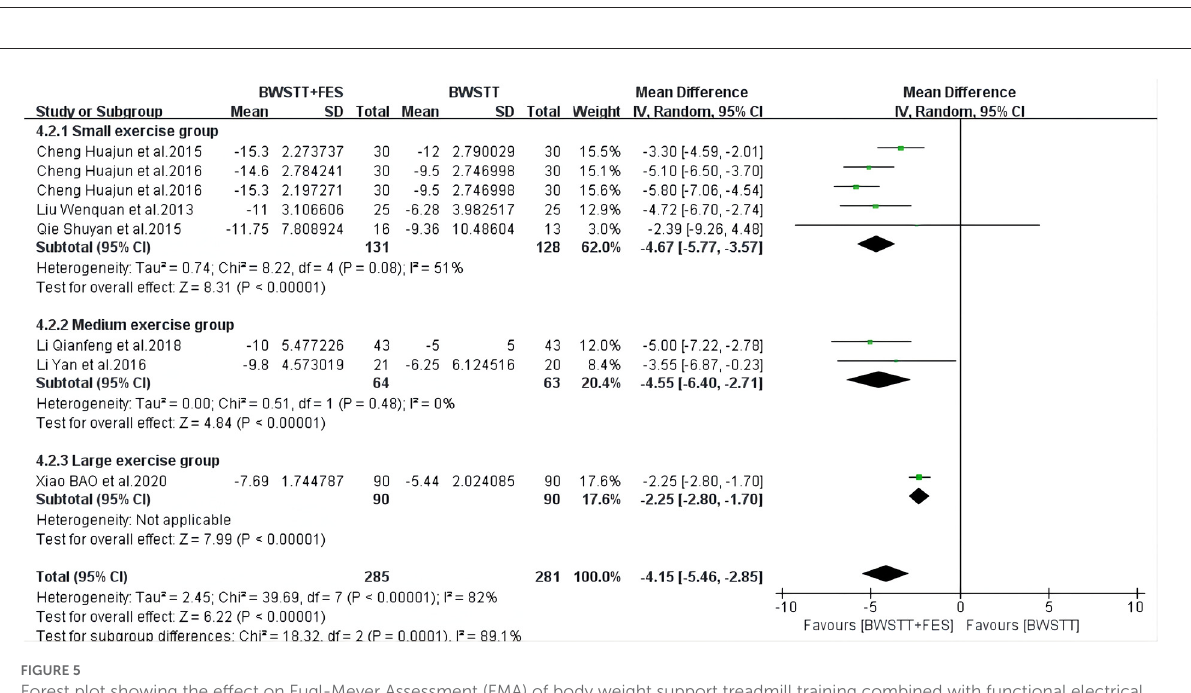
(Figure 8) of the small and medium exercise groups than BWSTT only. When compared to BWSTT only, BWSTT combined with FES had a significant effect on the BBS ( I 2 = 29%; p = 0.005) (Figure 9) and gait speed ( I 2 = 0%; p < 0.00001) (Figure 10)